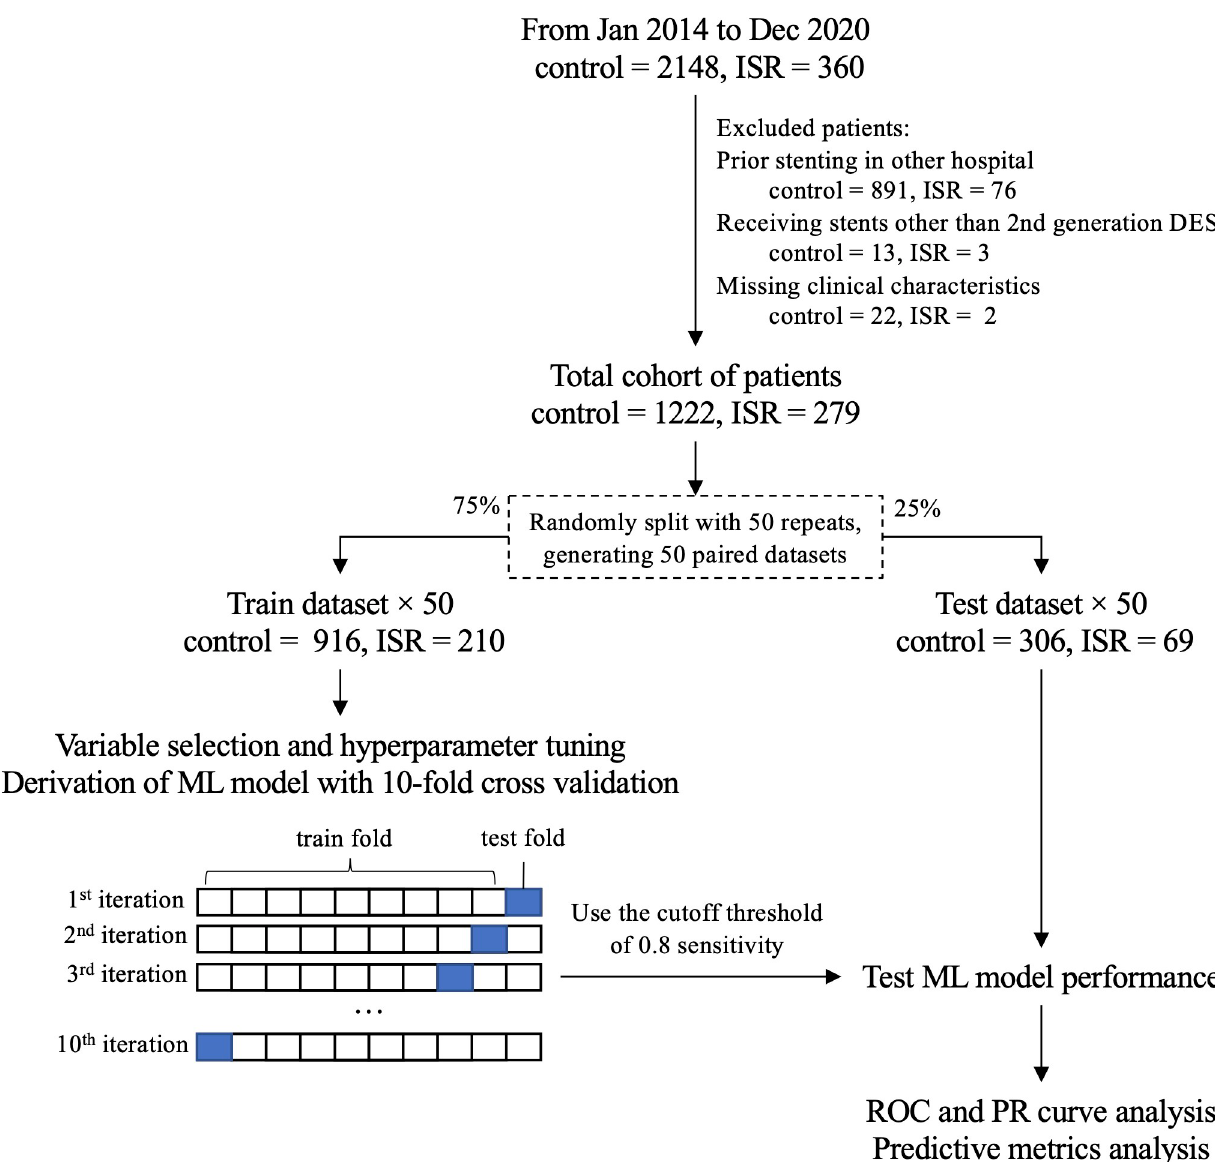
Fig 1. Overview of the data source and model development. Abbreviations: DES = drug-eluting stent, ISR = intra-stent restenosis, ROC = receiver operating characteristic, PR = precision-recall.